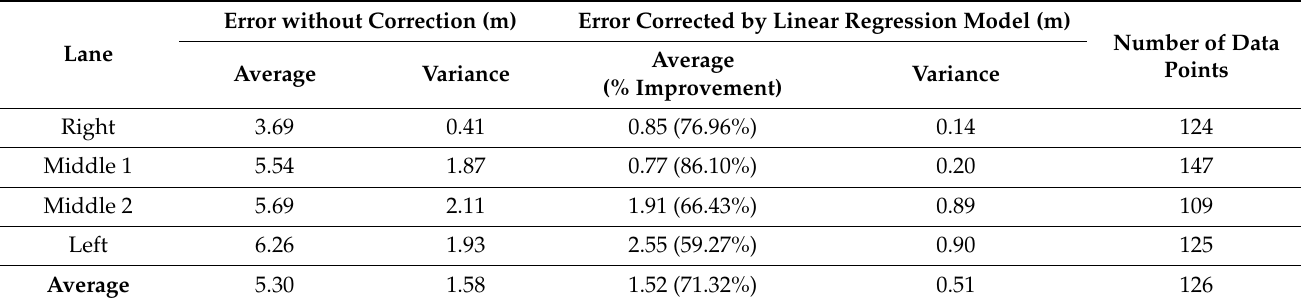
erage improvement of 71.32%. Table 2 . Comparison of vehicle localization error with respect to di ff erential GPS measurement in the world coordinates with and without center correction by a linear regression model .